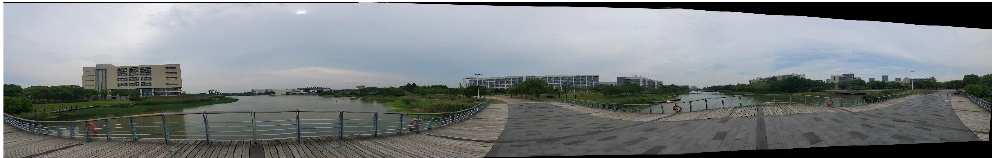
Figure 10. The result of stitching based on the binary tree model.